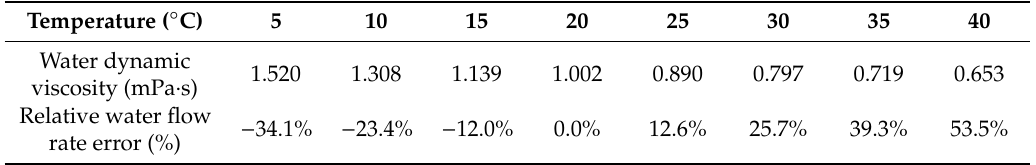
Table 1. E ff ect of dynamic viscosity change with temperature on relative flow rate accuracy of passive constant flow regulators. The reference temperature is 20 ◦